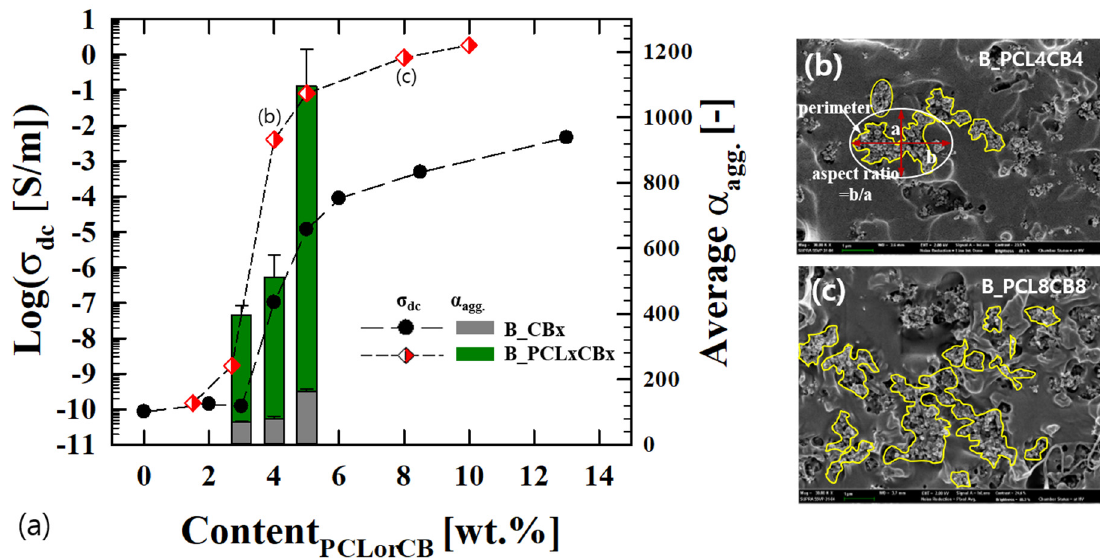
Figure 1. ( a ) DC conductivity ( σ dc ) and average aggregate size ( α agg. ) of B_CB x binary and B_PCL x CB x ternary composites depending on the PCL or CB content. As indicated in ( b ), each aggregate dispersed in the composite was selected and examined to characterize the aggregate size. ( c ) B_PCL8CB8 was difficult to characterize due to uncertain boundaries of the aggregates and the expanded percolated structure.